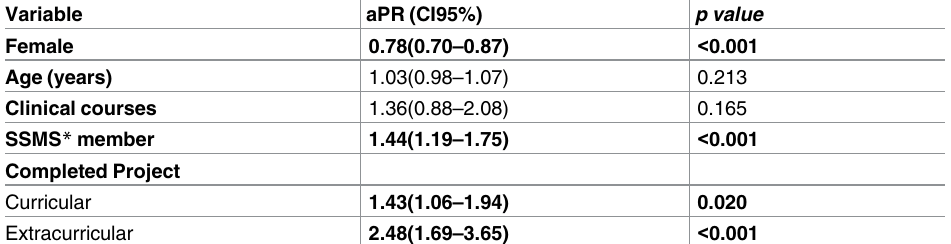
Table 4. Multivariate analysis of knowledge about Sci-Hub according to socio-educational variables among medical students from 6 Latin American